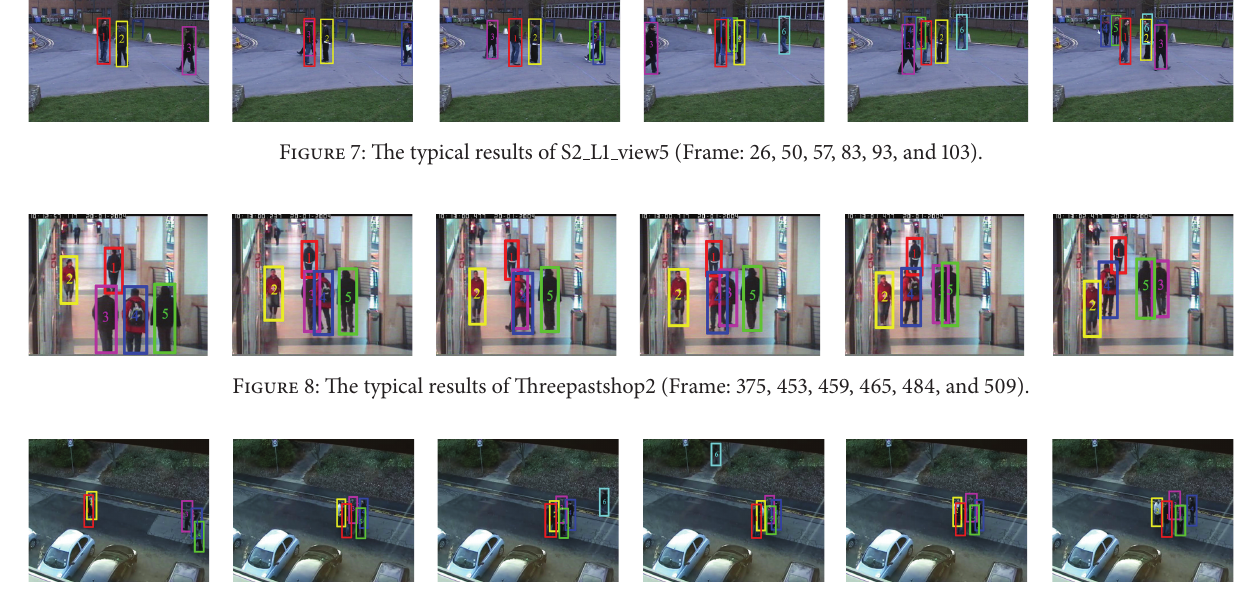
Figure 9: The typical results of Sequence3 (Frame: 2751, 2825, 3430, 3750, 3900, and 5010).